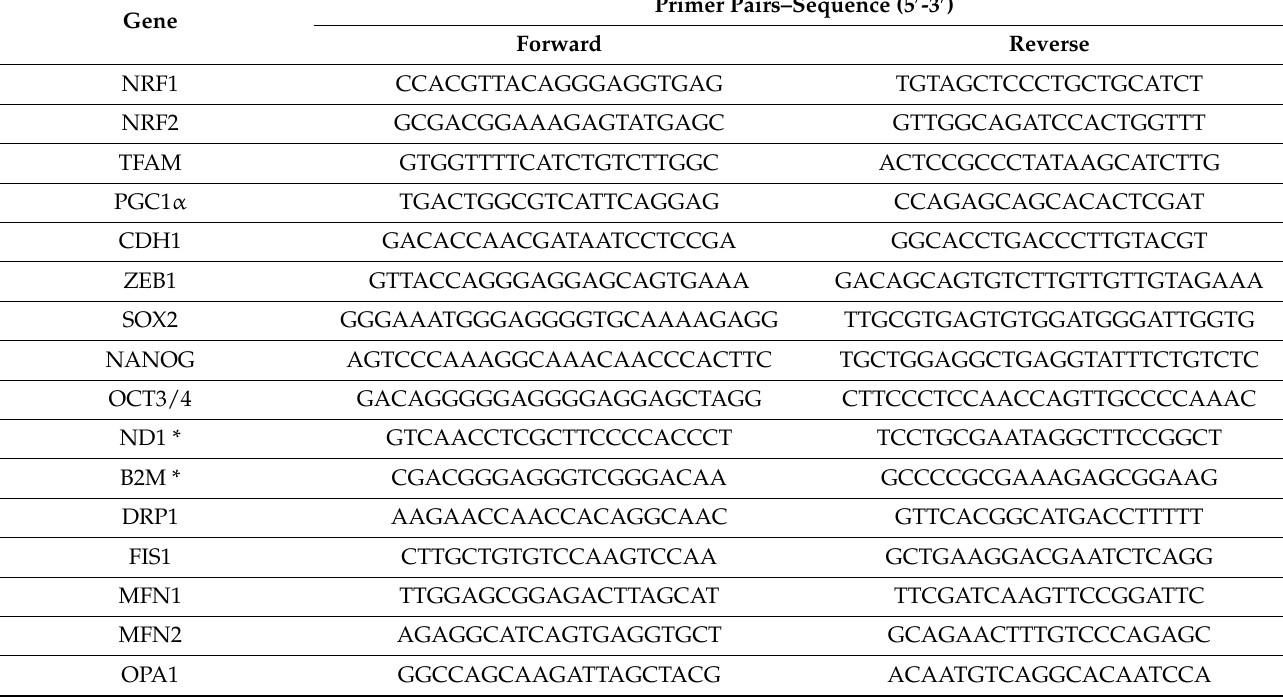
Table 1. List of human primer sequences used for real-time